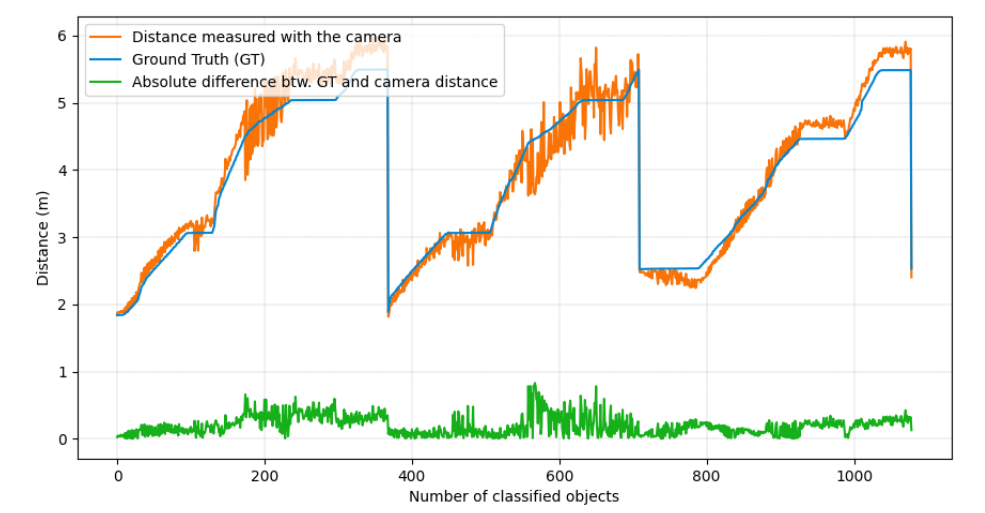
Figure 9. Measured distance between correctly classified objects and D 435 RealSense camera (orange), ground truth distance (blue), absolute value of the difference between the ground truth distance and the distance estimated by the camera (green). The detected objects are sorted by class, then detection order. The distribution of the relative distance measurement error is shown in Figure 10.